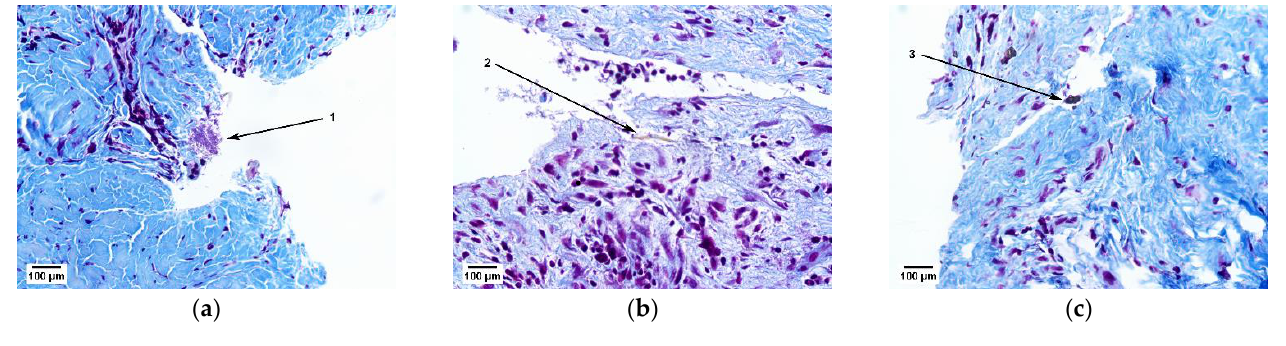
Figure 1. Results of the histological study of soft tissue samples of the patient ’ s fibrous capsules (Mallory staining): ( a ) granulation tissue at different stages of maturation; ( b ) maturing dense fibrous connective tissue; ( c ) foreign particles.